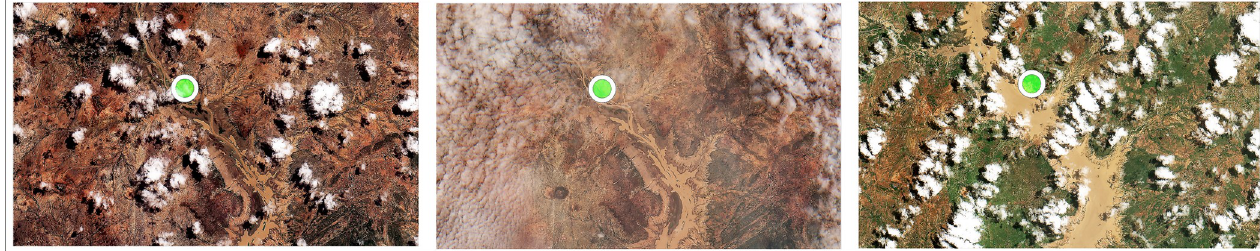
Fig 15. Evolution of the surface water area in the region of the routine measurement during the month of July 2018 (from left to right: Sentinel-2 images from 01/07/2018—https://theia.cnes.fr/atdistrib/rocket/#/collections/SENTINEL2/c0ff2b6e-1a94-5a31-b55f-c36f2b281d4c, 11/07/2018 - https://theia. cnes.fr/atdistrib/rocket/#/collections/SENTINEL2/fbbb8c73-7252-5310-80da-e2c2d9b4c4c4 and 31/07/2018 - https://theia.cnes.fr/atdistrib/rocket/ #/collections/SENTINEL2/e787630e-5d67-5cc6-9eee-cdc668ef92f0).